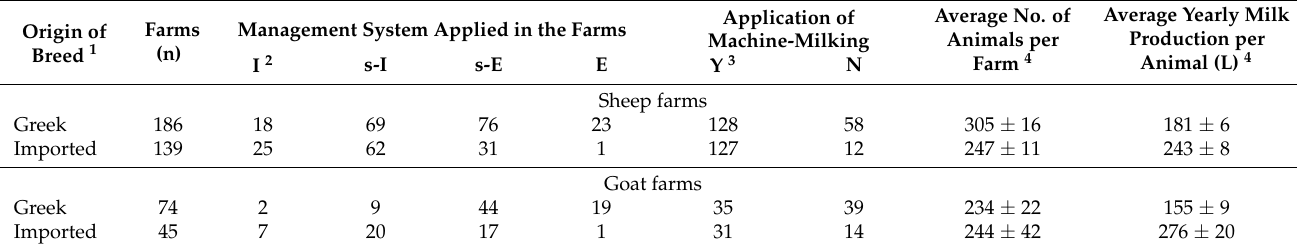
related between them, and each one prevailing only in some areas of the country with limited geographic dissemination. Table 2. Zootechnical characteristics of 444 small ruminant farms in Greece, summarized according to the origin of the breeds of animals therein.